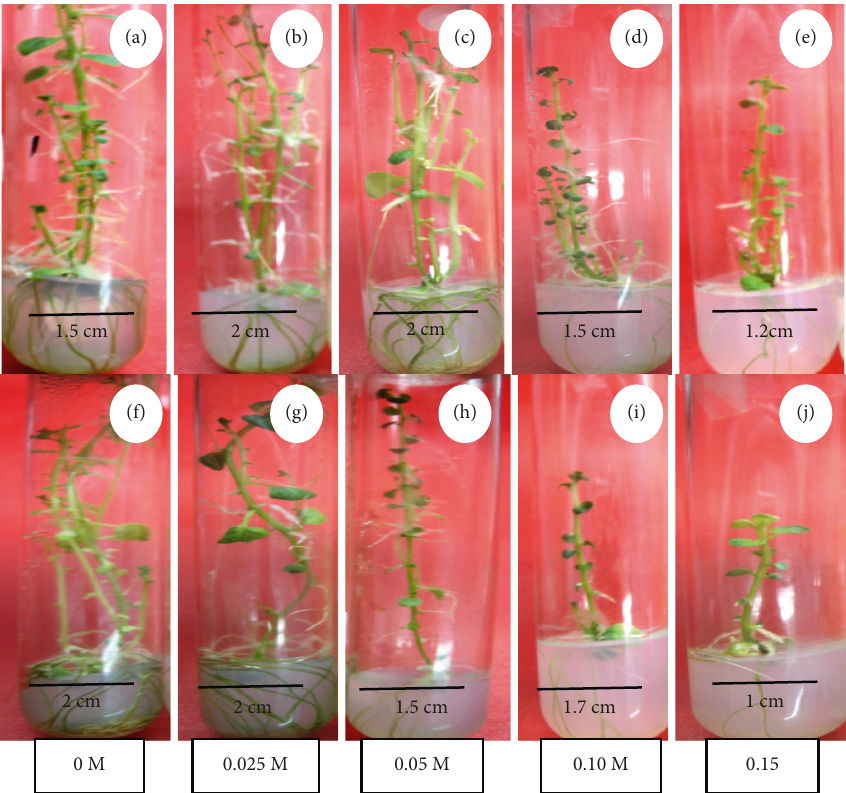
Figure 1: Growth of CVS. Cardinal (a)–(e) and Desiree (f)–(j) at different sorbitol concentrations. Scale bar. (a) � 1.5cm, (b)–(c) � 2.0cm, (d) � 1.5cm, (e) � 1.2cm, (f)–(g) � 2.0cm, (h) � 1.5cm, (i) � 1.7cm, and (j) � 1.0